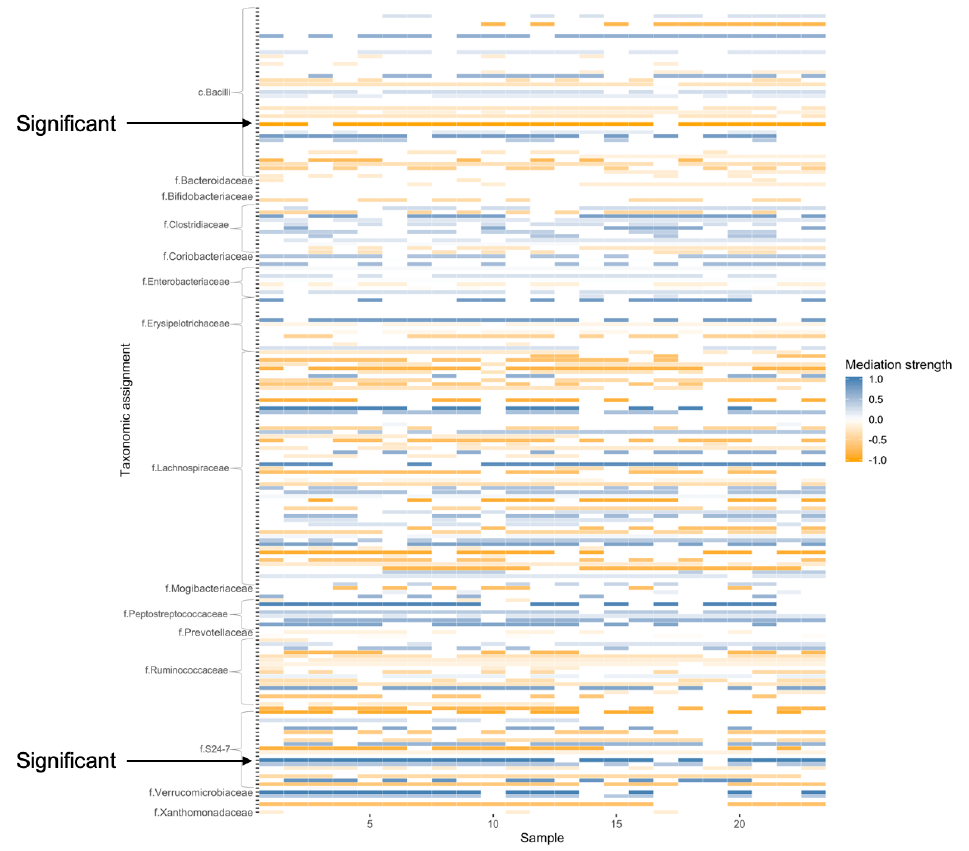
Figure 2. Heatmap of mediation strength based on NIE 1 in VSL#3 study. The mediation strength is measured by (1- p ) where p is the unadjusted p -value. Negative sign indicates negative NIE 1 . Taxonomic assignment is labeled on the vertical axis. Samples are labeled on the horizontal axis. Absence of an OTU in a sample is left blank in the